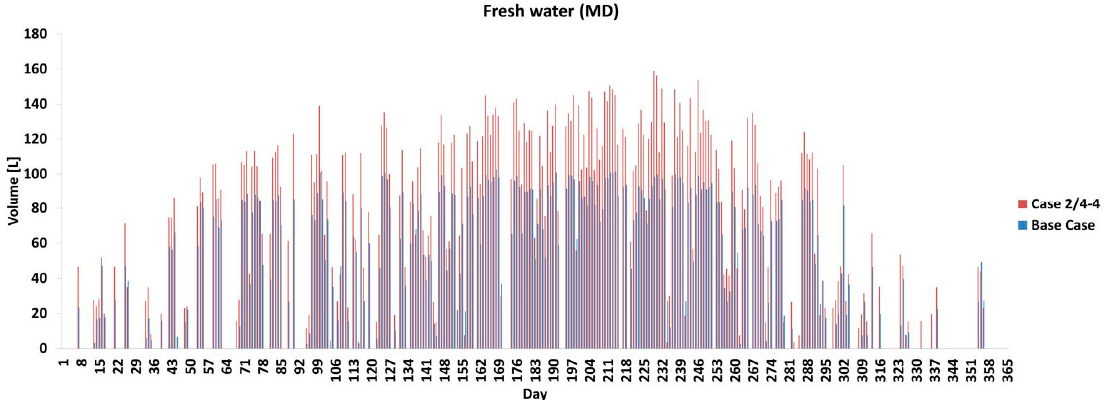
Figure 13. MD production in the base and optimum design cases.